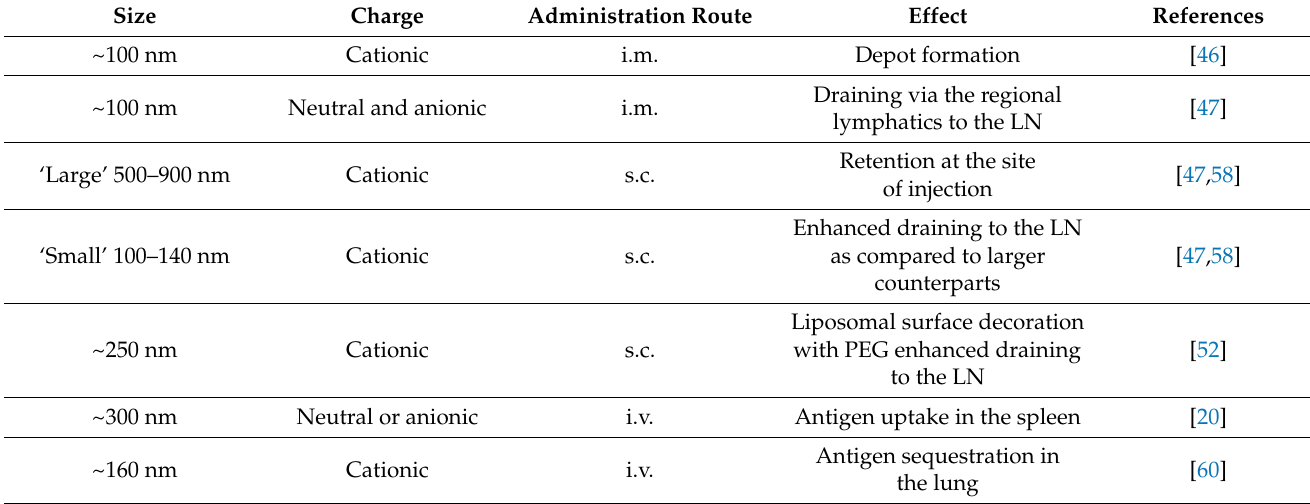
Table 1. Physicochemical properties of liposomes determine liposomal behavior upon